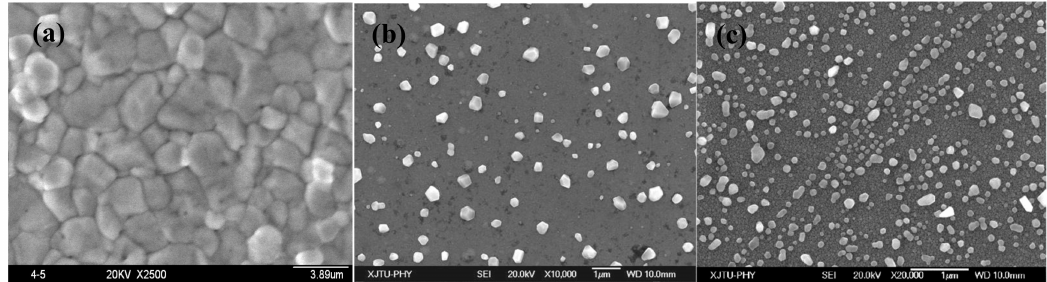
Figure 6. The surface morphologies of Cu–Zr films after annealing at 300 ◦ C with di ff erent compositions, ( a ) Cu-0%Zr, ( b ) Cu-7.3%Zr, and ( c ) Cu-12.3%Zr.